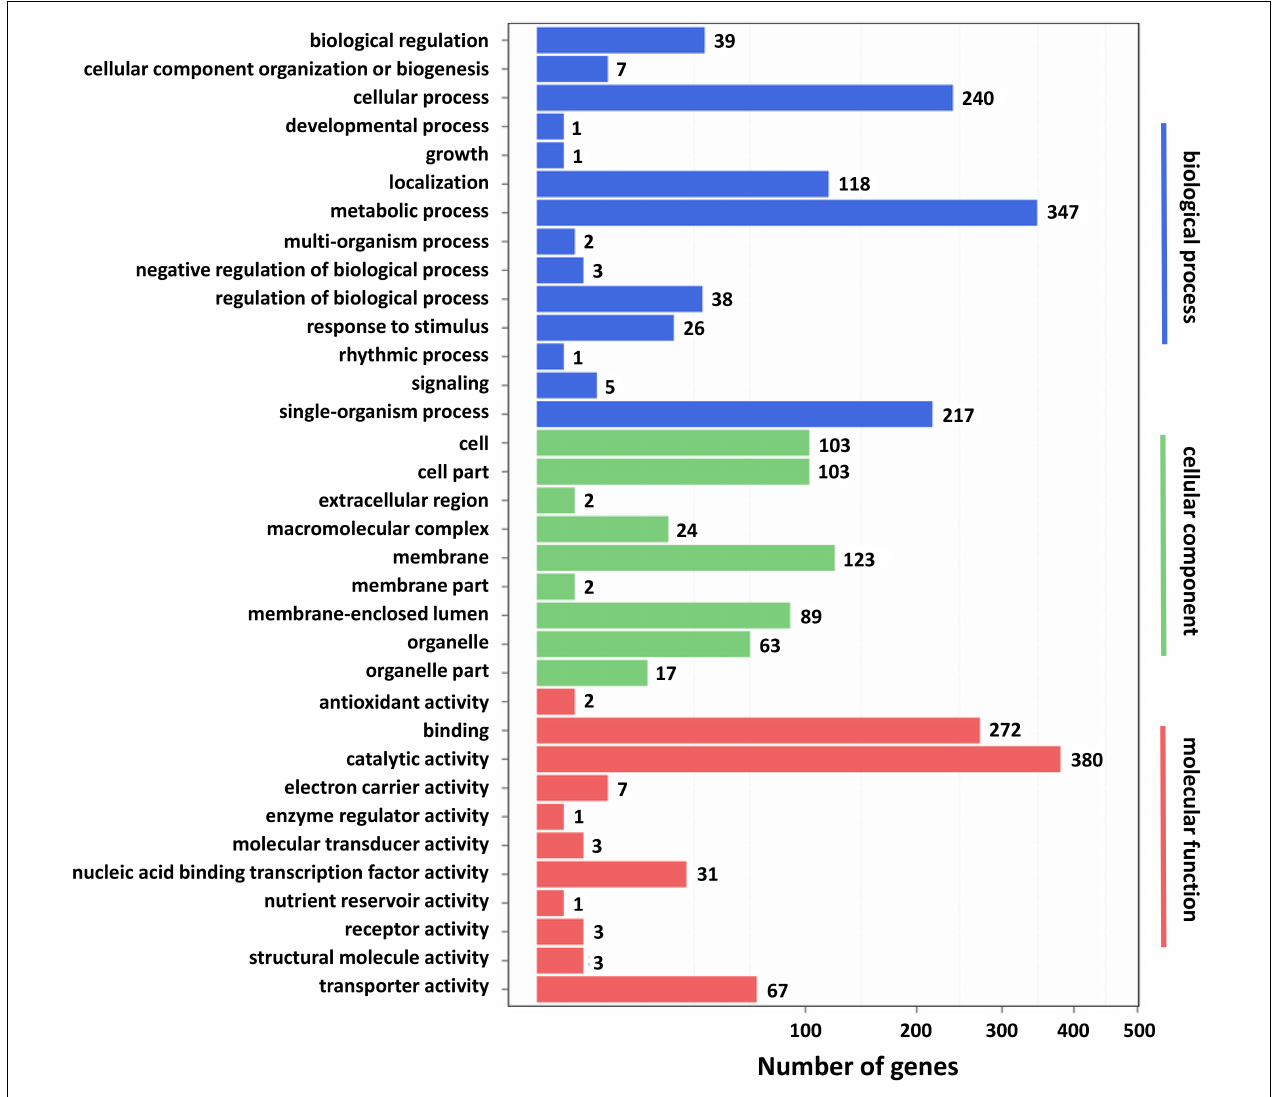
FIGURE 2 | Gene ontology (GO) classification of differentially expressed genes (DEGs). X axis represents the number of DEGs. Y axis represents the GO